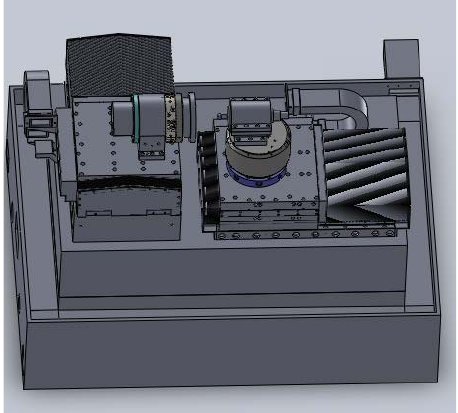
Figure 4. Three ‐ dimensional model of machine tool. Figure 4. Three-dimensional model of machine